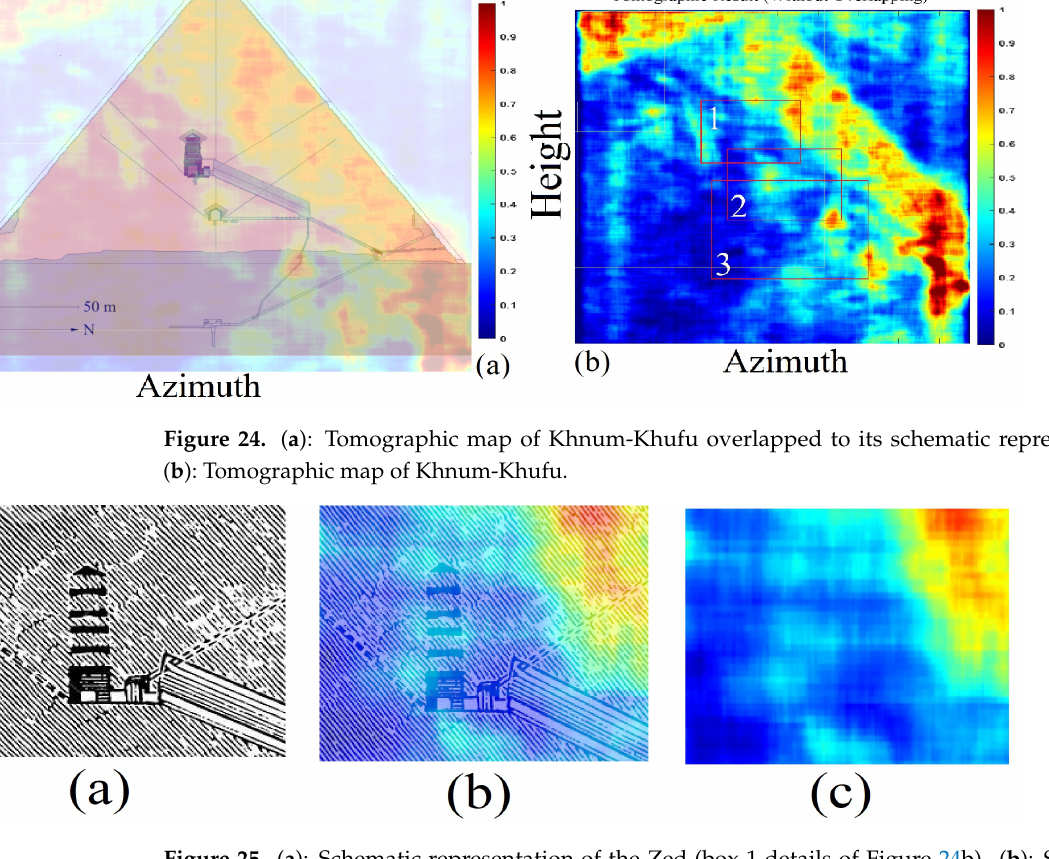
Figure 25. ( a ): Schematic representation of the Zed (box 1 details of Figure 24b). ( b ): Schematic representation of the Zed (box 1 details of Figure 24b) partially overlapped to tomographic result. ( c ): Figure 24b box 1 details tomographic